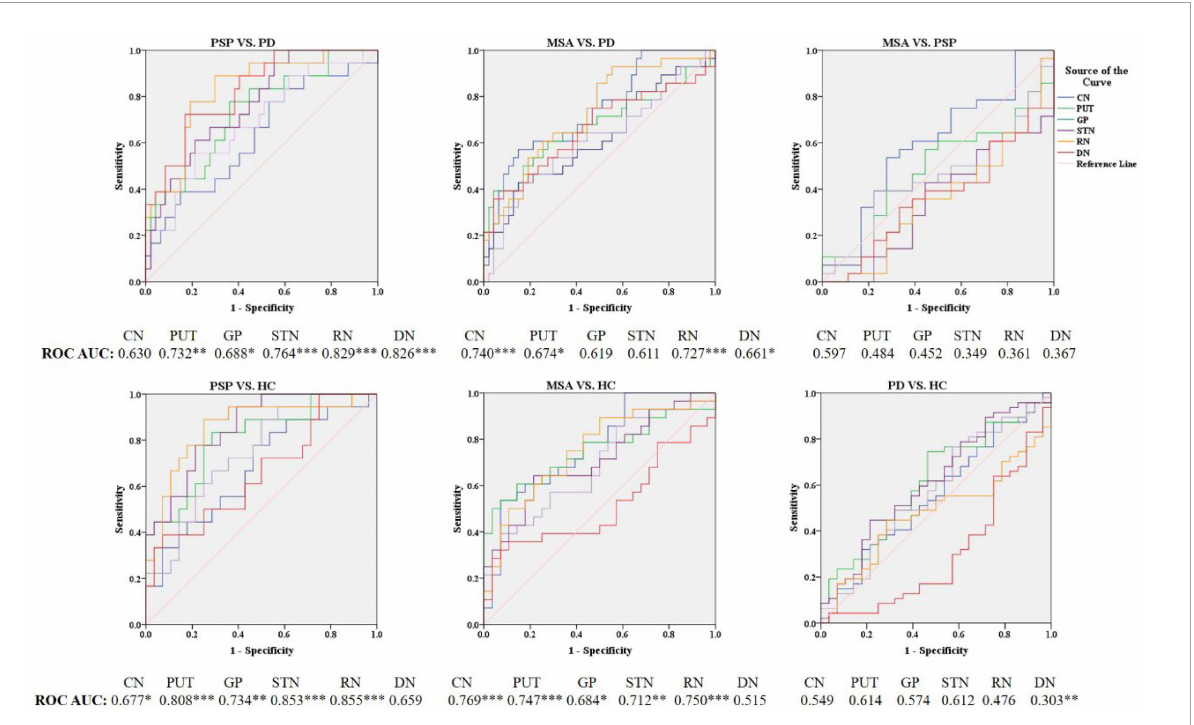
FIGURE3 Receiver operating characteristic (ROC) curves showing comparisons in the regions of interest between parkinsonian disorders and HC. ∗ P < 0.05, ∗∗ P ≤ 0.01, ∗∗∗ P ≤ 0.001. CN, caudate nucleus; PUT, putamen; GP, globus pallidus; SN, substantia nigra; RN, red nucleus; DN, dentate